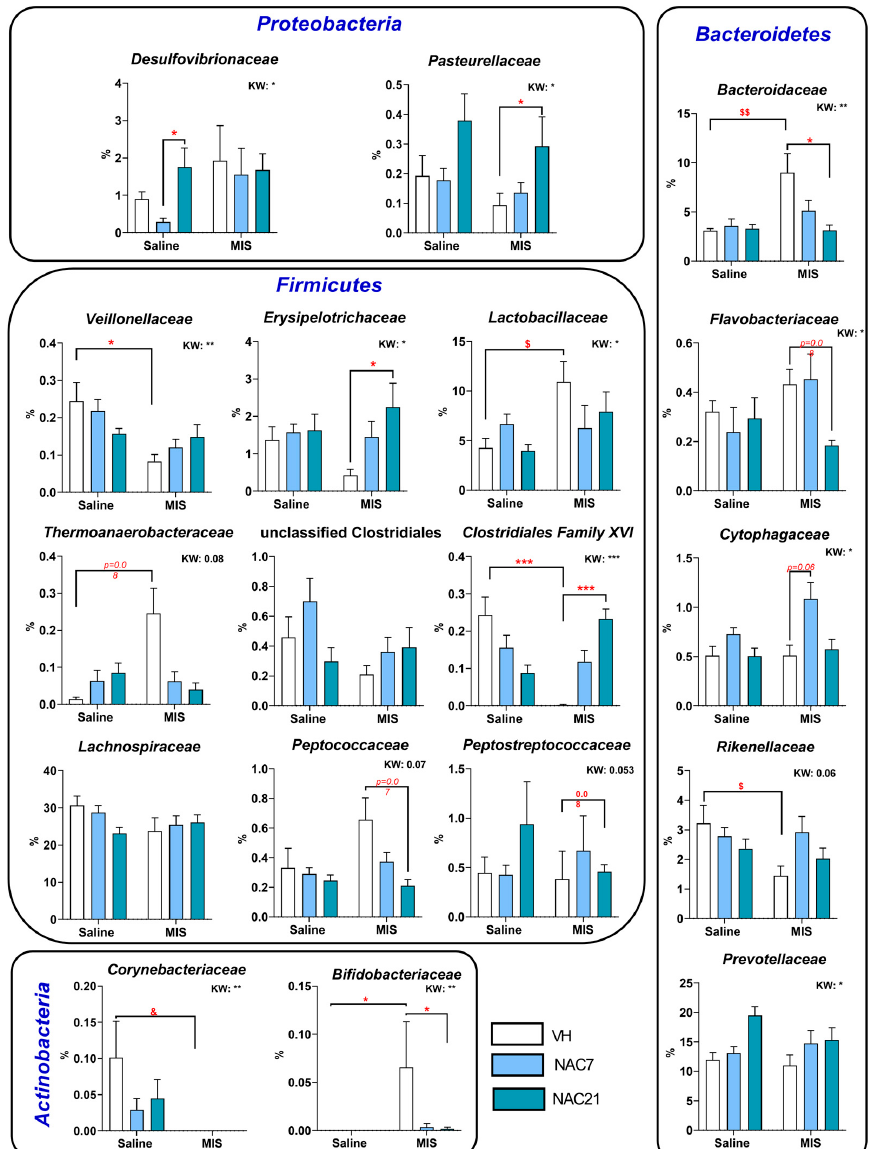
Figure 4. Gut microbiota composition at the family level. Selection of the most representative microbiota families altered in the MIS model and modified by NAC treatment. Each column shows the average of % changes in the composition of microbiota at the family level. (Saline-VH: 8, Saline- NAC7: 11, Saline-NAC21: 11, MIS-VH: 11, MIS-NAC7: 11, MIS-NAC21: 11). Data is shown as mean ± SEM. Kruskal–Wallis (KW) analysis followed by Dunn(cid:31)s multiple comparison test (* p < 0.05, ** p < 0.01, *** p < 0.001) and Mann–Whitney test ( $ p < 0.05, $$ p < 0.01) are shown. At the genus and species level (Figure 5 and Supplementary Table S3), statistically, signi fi cant di ff erences were mainly found in Firmicutes phylum taxa. Lactobacillus was in- creased in MIS-VH vs. Saline-VH animals, and the same phenomenon occurred in L. in- testinalis and L. kitasatonis species. Importantly, NAC7 and NAC21 treatments were able to reduce these increases in MIS animals, although the statistical signi fi cance of this re- duction was only observed in the L. kitasatonis MIS-NAC21 group. Acetatifactor